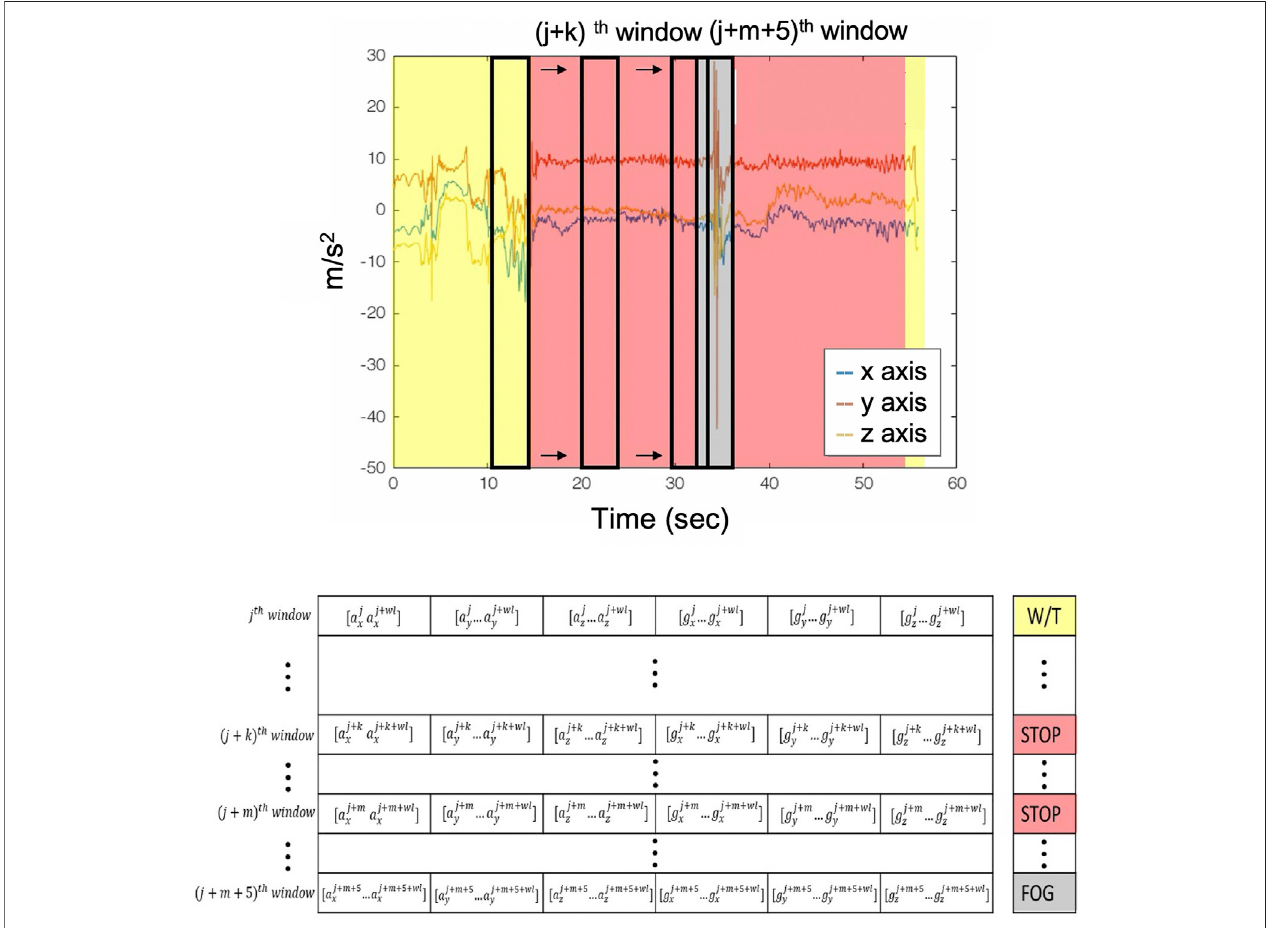
FIGURE2| Slidingwindowandlabelingprocedure.Yellowareasarethewalkingwithturnrecordings;theredareasdepictthestopevent;andthegrayonesdepict the FoG event.